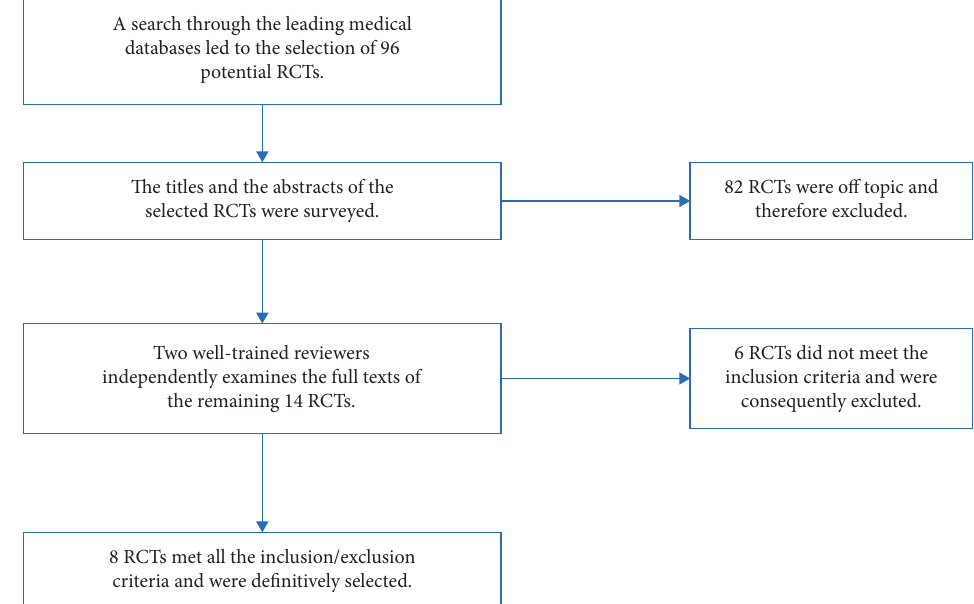
Figure 1: Flowchart showing the selection process for studies meeting the inclusion/exclusion criteria. RCTs, randomized clinical